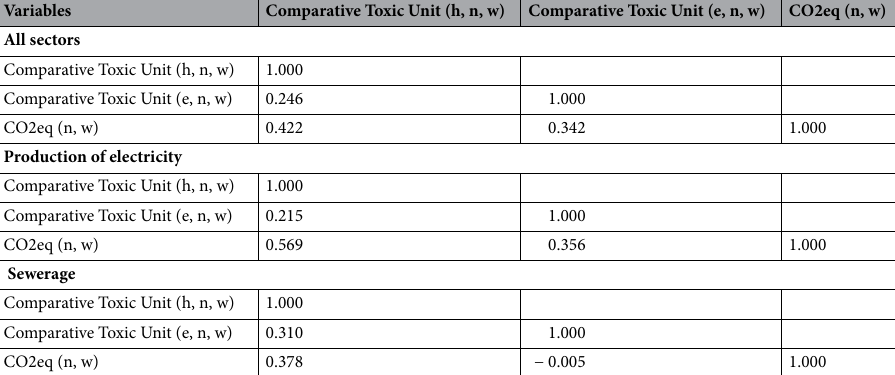
Table 5. Cross-correlation (Facility level observations by all sectors and sectors with the largest impact potentials) h: comparative toxic unit for human toxicity, e: comparative toxic unit for ecotoxicity, n: normalized values, winsorized